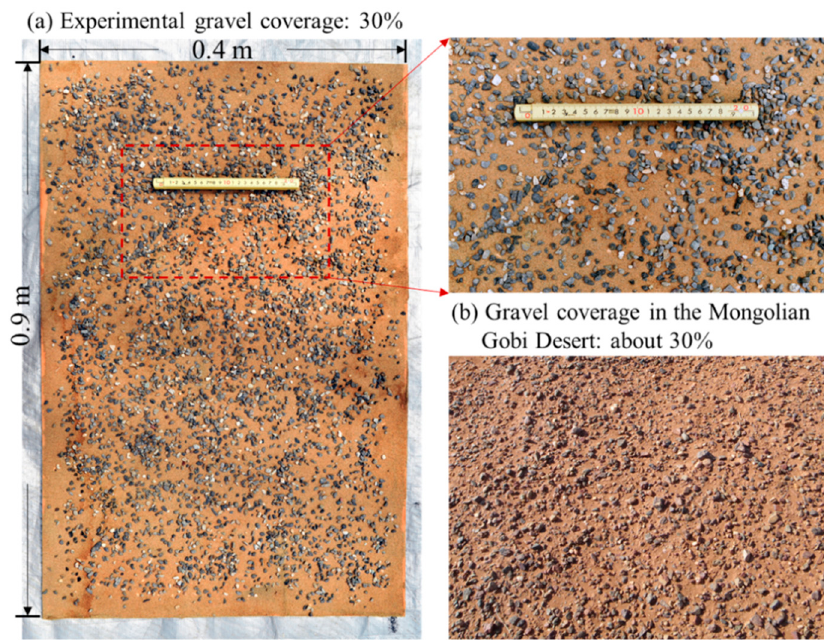
Figure 4. Photographs for comparison of gravel size and coverage of 30% ( a ) in our wind tunnel experiments and ( b ) in the Mongolian Gobi Desert.